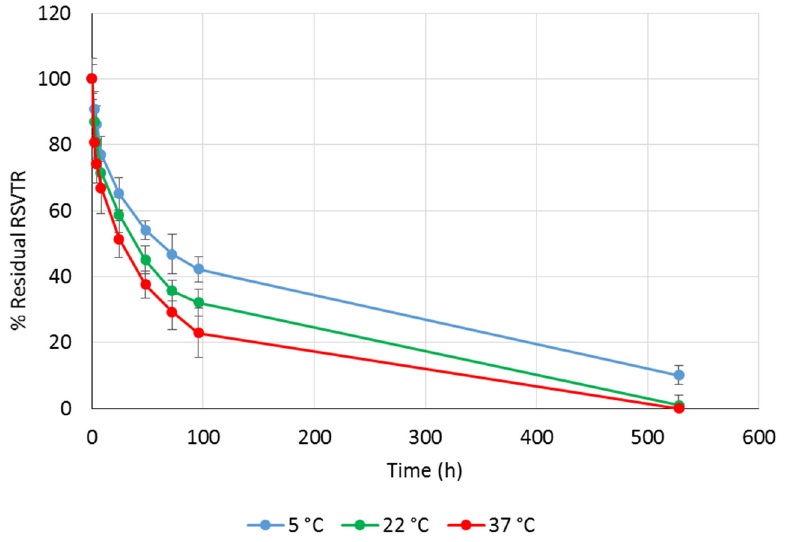
Figure 5. Percentage of residual RSVTR vs. time after incubation at pH 2.0 and different tempera- tures. Table 2. Half-life (h) of resveratrol triester with trolox after incubation at different pH values and different temperatures.